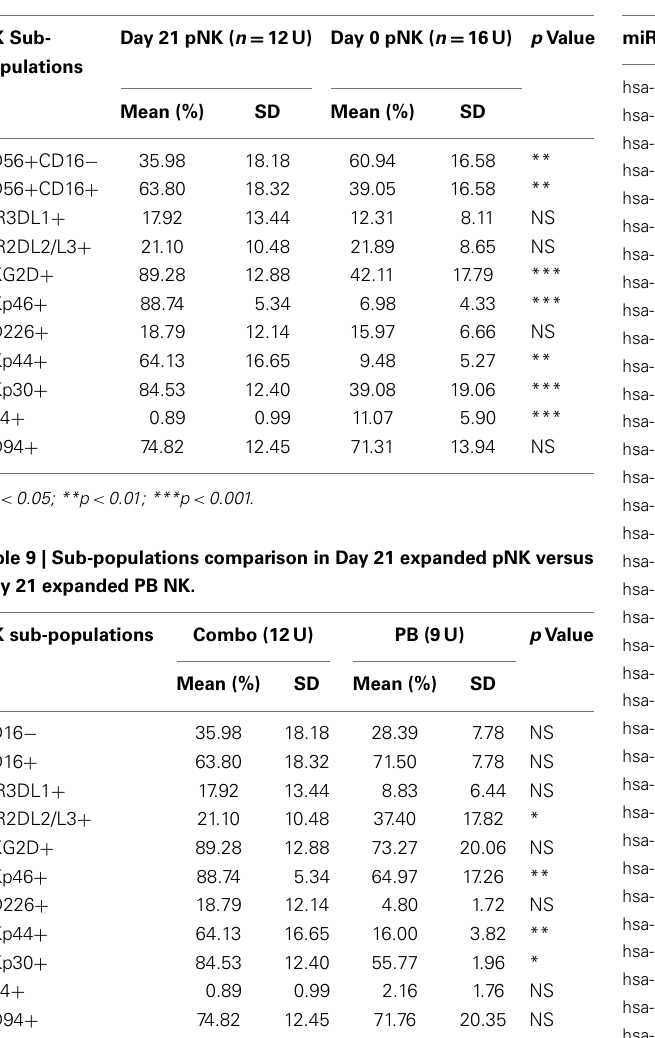
Table 10 | Differentially regulated miRNAs during pNK ex